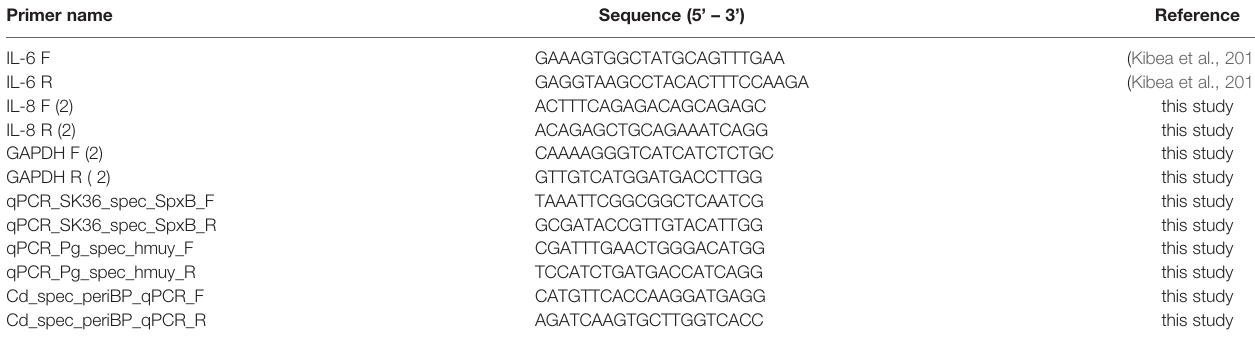
TABLE 1 | Oligonucleotides used for